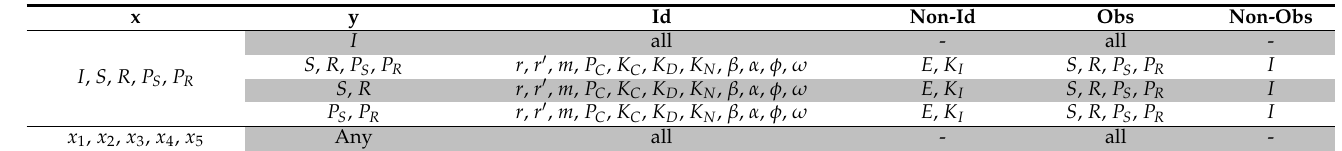
Table 5. PC. Results for the phage cocktail